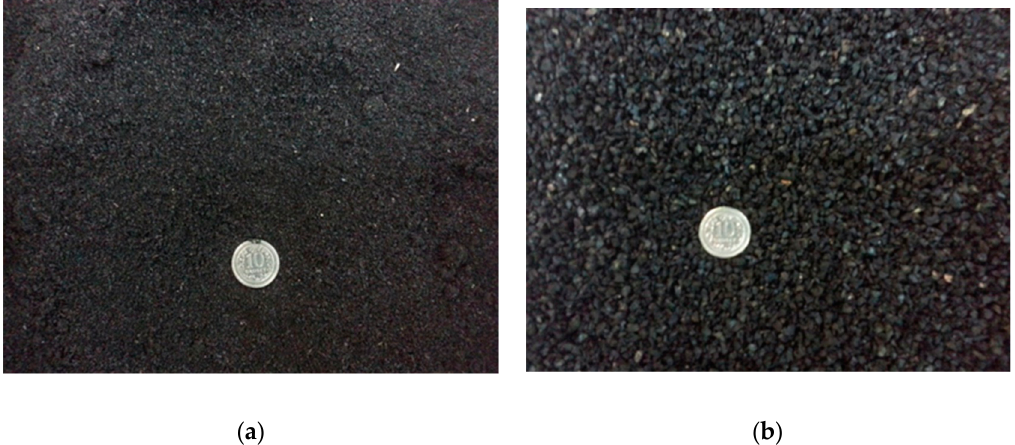
Figure 1. Rubber waste: ( a ) powder (P) 0–1 mm, ( b ) granulate (G) 1–5 mm. Table 2. Physical properties of the red clay (siCl/CH), powder (P) and granulate (G), based on the grain-size distribution curves [16,43].